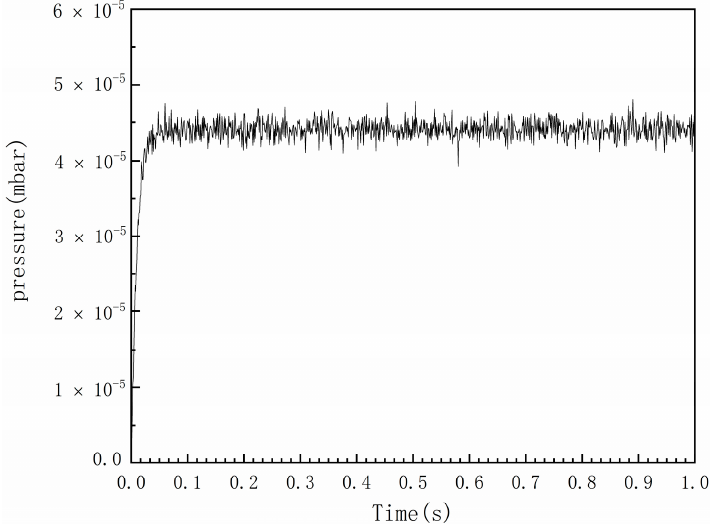
Figure 6. The change in the average pressure of the neutralized area of the vacuum chamber over time during the 1 s pulse.